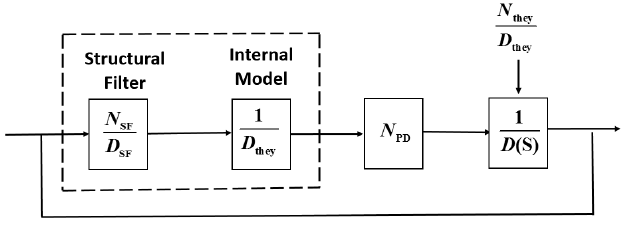
Figure 5. Active disturbance rejection control system. SF: structural filter.